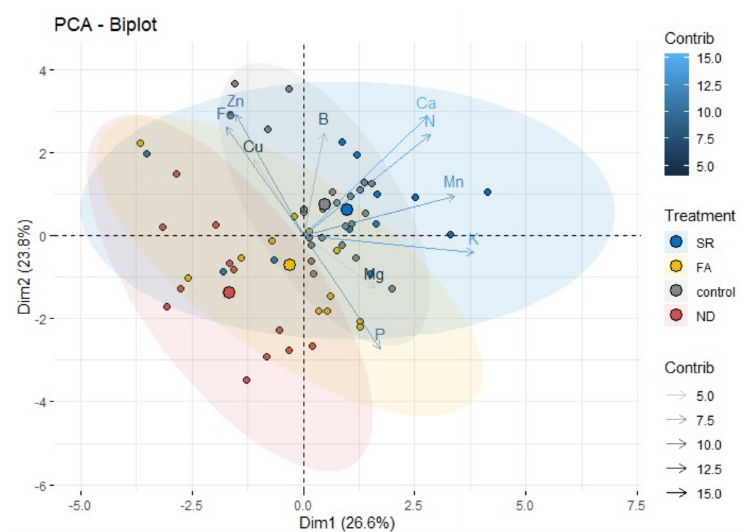
Figure 6. Biplot showing positive and negative correlations of mineral nutrients to the first and second principal components derived from PCA. Dots represent individual plants. Arrows indicate explanatory variables as vectors, and the contribution is represented by their color and shade. The centroid of each ellipse is presented with a larger